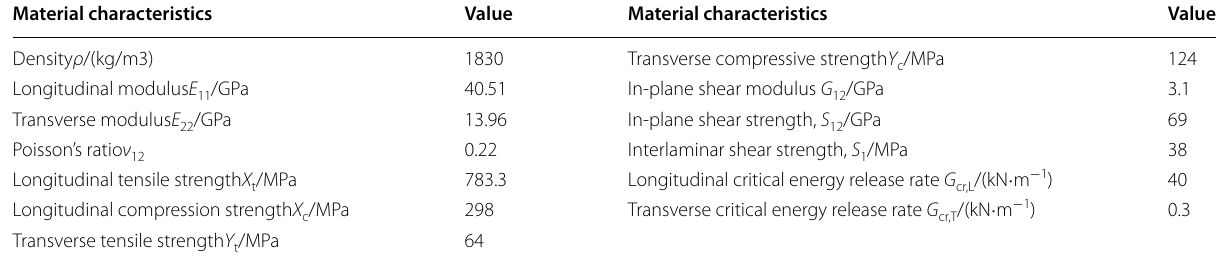
Table 2 Characteristic parameters of composite material Material